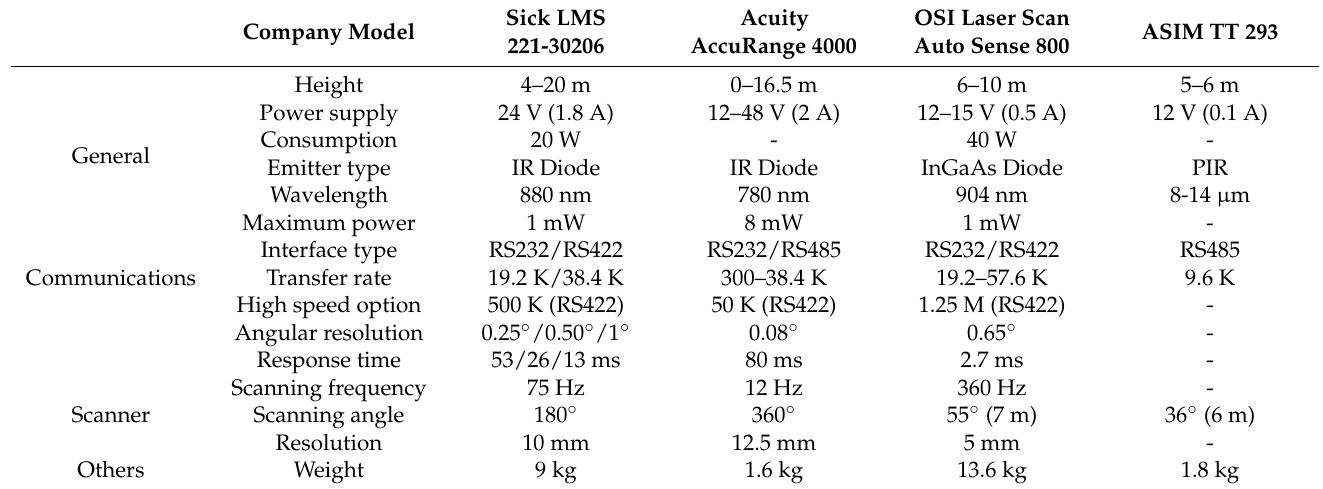
Table 1. Comparison between commercial